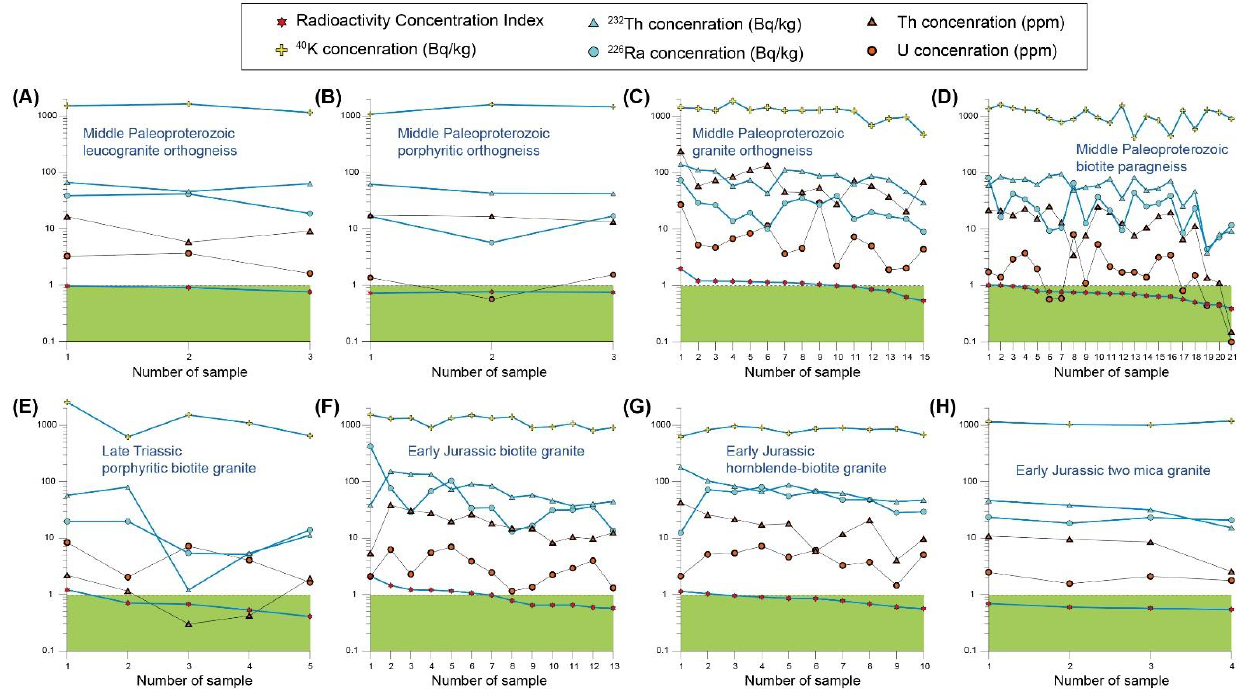
Figure 10. Plots of U and Th concentrations of geochemical analysis and the activity concentrations of 226 Ra, 232 Th, 40 K and RCI values for ( A – D ) Middle Paleoproterozoic granite orthogneisses, ( E ) Late Triassic porphyritic biotite granite, ( F ) Early Jurassic biotite granite, ( G ) Early Jurassic hornblende biotite granite, and ( H ) Early Jurassic two mica granite in the Jangsu-gun area.